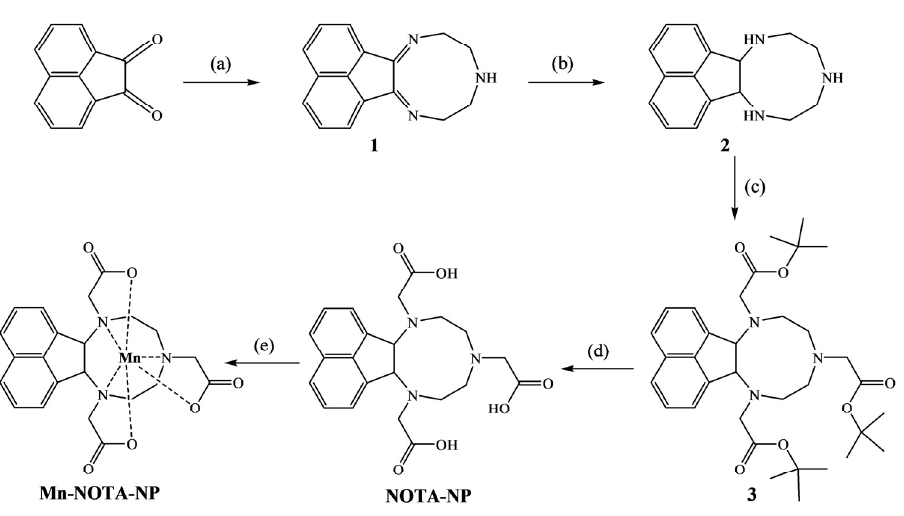
Table 1. Relaxivities and lipophilicity of Mn-NOTA-NP , Mn-EDTA, Mn-DPDP, Gd-DTPA, Gd-DTPA- EOB, and Gd-BOPTA in water and human serum albumin (HSA) at 3 T (297